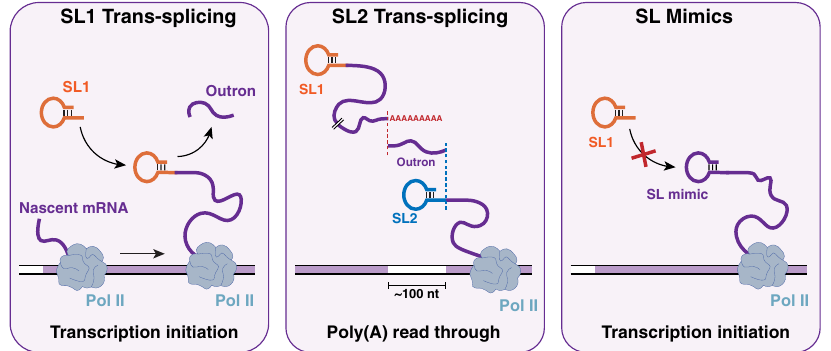
Fig. 7 | Three types of C. elegans mRNA 5 ’ extremities. mRNAs derived from gene adjacent to their promoters receive mostly SL1. SL2 is preferentially trans -spliced to genes located ~100 nt downstream of another gene. Non- trans- spliced mRNAs have 5 ’ self-complementarity that mimics the structure of